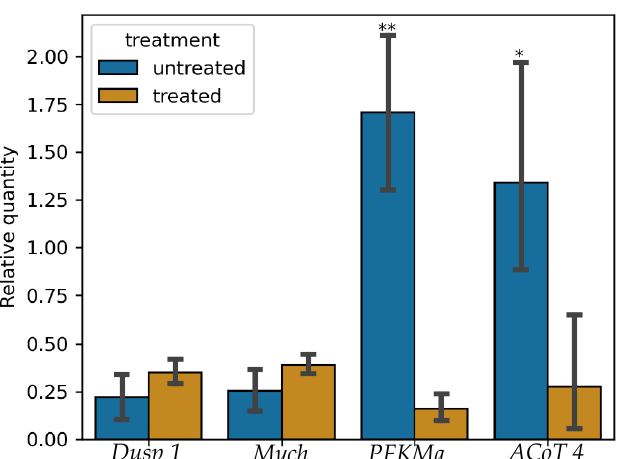
Figure 11. Transcript abundance of DUSP 1 , Mych , PFKMa , and AcoT4 when Nile tilapia was stressed with 0.12 mg/L of ammonia and stocking density of 70 fish per tank measured by RT-qPCR (one-way ANOVA; * indicates p ≤ 0.05 while ** indicates p ≤ 0.001).